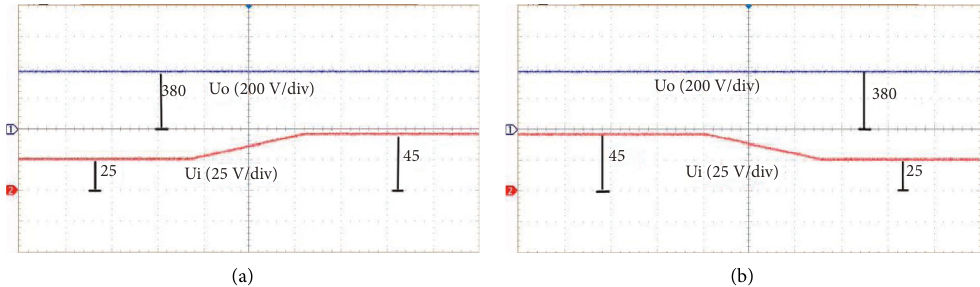
Figure 17: The waveforms of U o , when U i changes. (a) U i changes from 25 V to 45V, (b) U i changes from 45V to